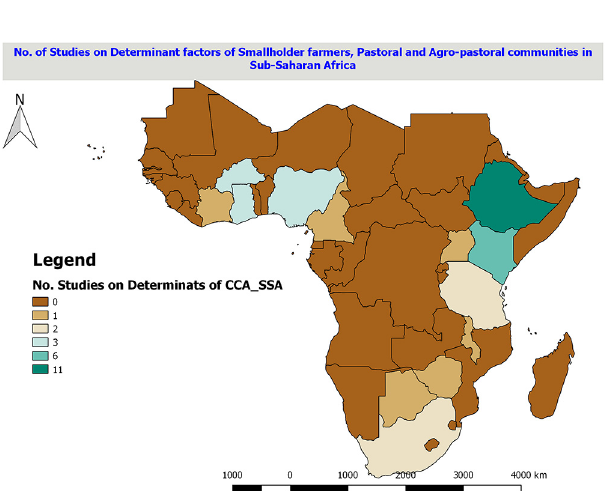
Figure 1. Results of the